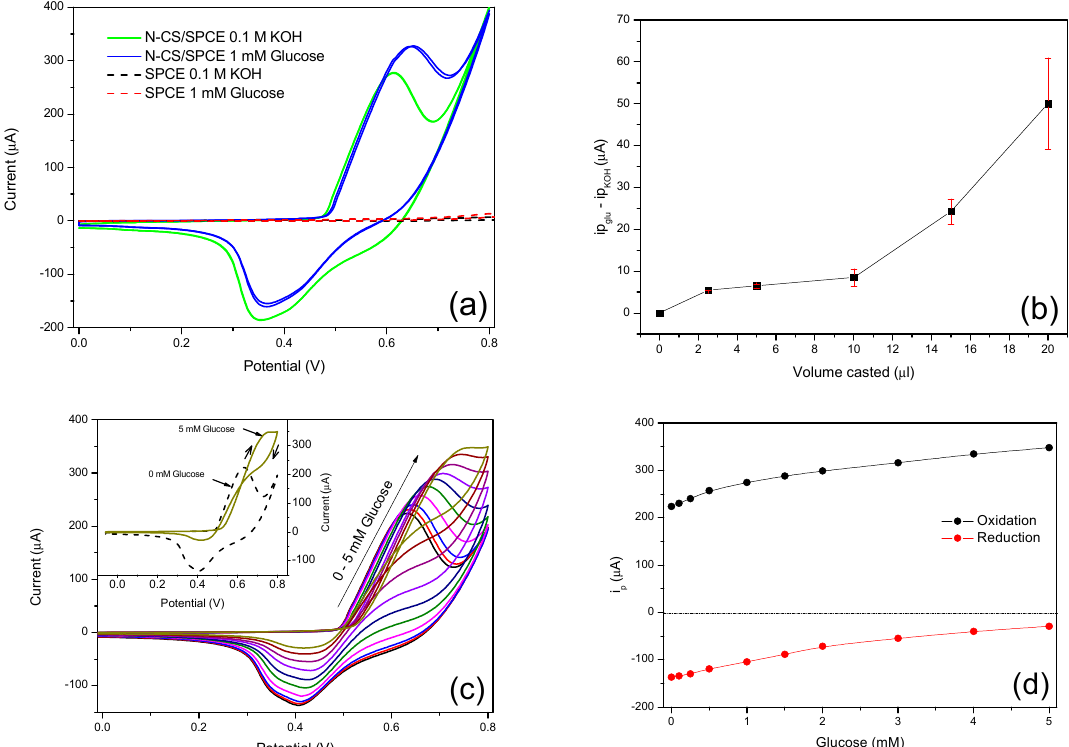
Figure 3. ( a ) CVs of bare SPCE and N-CS-modified SPCE in the absence and presence of 1 mM glucose in 0.1 M KOH at a scan rate of 50 mVs − 1 . ( b ) Response to 1 mM glucose of N-CS modified SPCE as a function of different amounts of active material casted on a working electrode surface. ( c ) CVs of 20 µ L N-CS modified SPCE for different concentration of glucose (0–5 mM) in 0.1 M KOH at a scan rate of 50 mVs − 1 ; inset: highlighting of CV curves in the absence and presence of 5 mM glucose. ( d ) Behavior of anodic and cathodic peak currents as a function of glucose concentration.